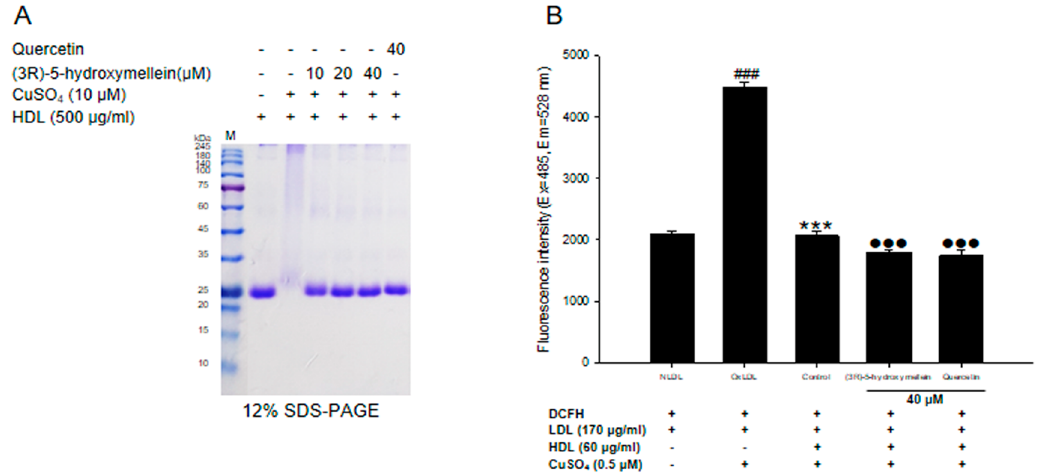
Figure 4. Effects of (3 R )-5-hydroxymellein on apoA-I aggregation and anti-LDL oxidation in oxidized HDL. ( A ) SDS-PAGE of oxidized HDL by 10 μ M copper ion for 4 hr in the absence or presence of extract (at 10, 20, and 40 μ M). ( B ) Inhibitory effect of (3 R )-5-hydroxymellein treated-HDL on LDL oxidation. Quercetin used as a positive control. ### p < 0.001 vs. NLDL (native LDL); *** p < 0.001 vs. oxLDL (oxidized LDL); ●●● p < 0.001 vs. control.